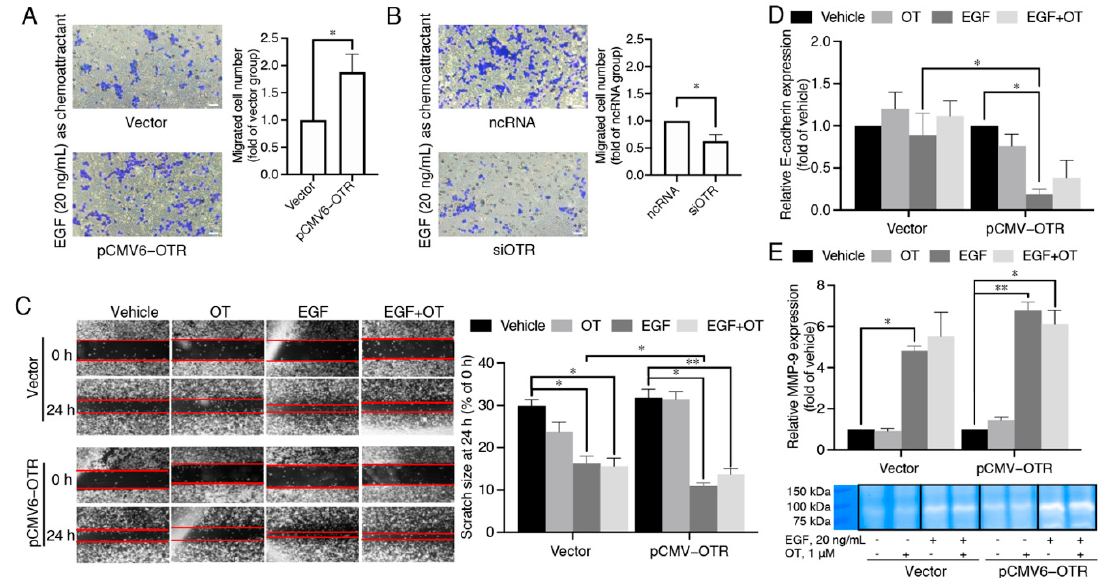
Figure 4. High oxytocin receptor expression correlates with high sensitivity to EGF-stimulated migration. ( A , B ) Effects of OTR overexpression or knock-down on EGF-guided MDA-MB-231 cell chemotaxis obtained from experiments conducted at the same time (10× objectives, scale bar (bottom right, white) = 41.86 μ m, n = 3 independent experiments with triplicates). Vector group, the control MDA-MB-231 cells transfected with the vector plasmid; pCMV6-OTR group, MDA-MB-231 cells transfected with the pCMV6-OTR plasmid; ncRNA group, the control MDA-MB-231 cells transfected with the non-targeting control RNA; siOTR, MDA-MB-231 cells transfected with OTR-targeting siRNA SMARTpool. ( C ) Effects of OTR overexpression or knock-down on cell migration tested by a scratch wound healing assay. Photos were taken using a Nikon Ti-U inverted fluorescence microscope at 0 h and 24 h after scratches were made (20× objectives). ( D ) mRNA expression of the metastasis marker E-cadherin in MDA-MB-231 cells with or without OTR overexpression treated by EGF (20 ng/mL) and/or OT (1 µ M). ( E ) Comparison of MMP-9 activity in MDA-MB-231 cells with or without OTR overexpression treated by EGF (20 ng/mL) and/or OT (1 µ M) determined by a gelatin zymography assay. The bands were derived from the same gel. The bar graph quantifies MMP-9 bands by densitometric analysis. Vehicle group, MDA-MB-231 cells without EGF/OT treatment. Statistical analysis for ( A , B ) included the Student’s t -test. Statistical analysis for ( C – E ) included ANOVA analysis followed by Tukey’s multiple comparisons test. n ≥ 3 independent experiments, *, p < 0.05, **, p <